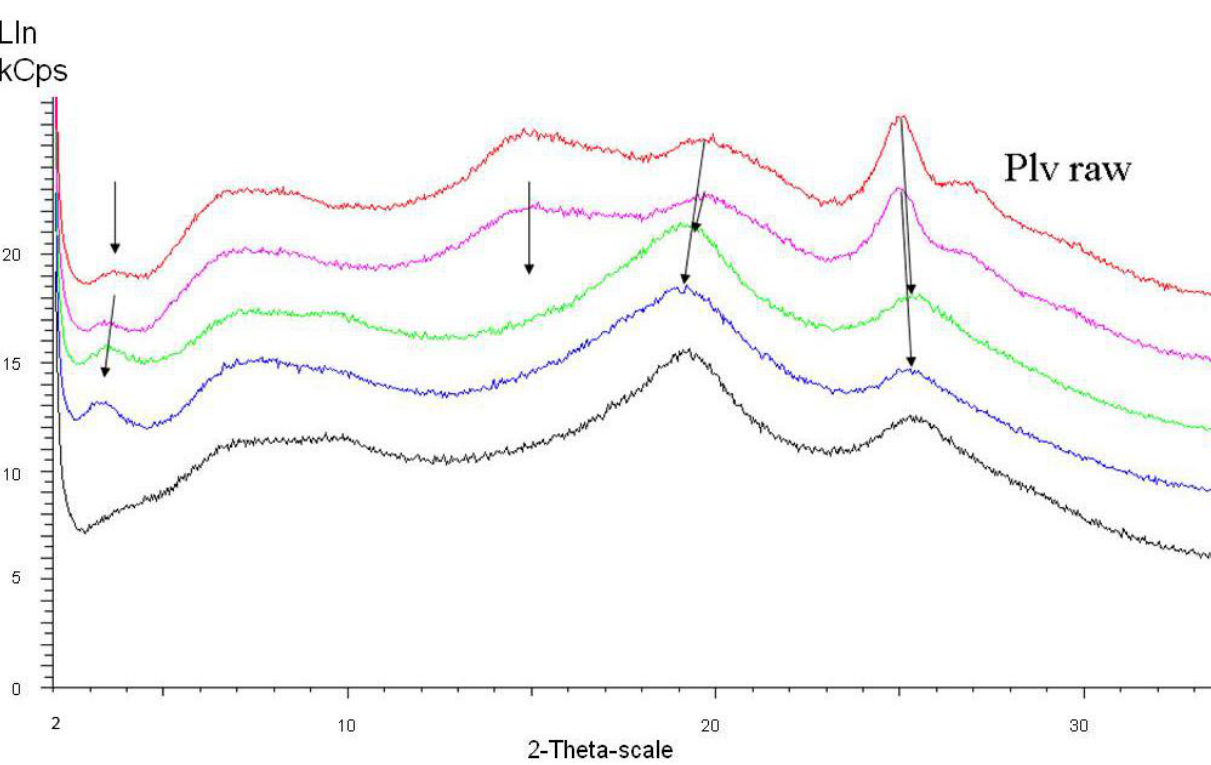
Figure 6. X-ray diffraction of polyaniline starting with the raw powder (red curve), following the progress of dispersion in the first dispersion step (from purple over green to blue curve, the latter representing the final stage of the first dispersion step); the black curve represents the same material as the blue curve after extracting all dispersion